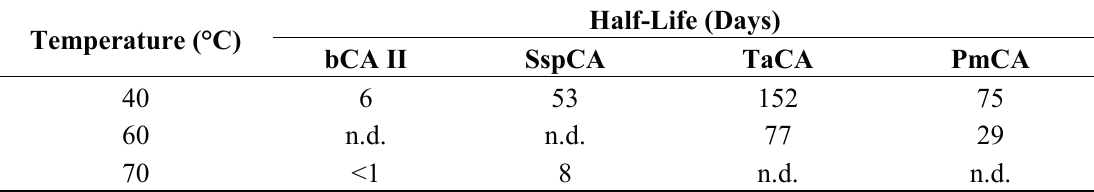
Table 2. Long-term stability of some thermostable α -CAs at different temperatures. Data on bovine CA II (bCA II) have also been reported for comparison [45].